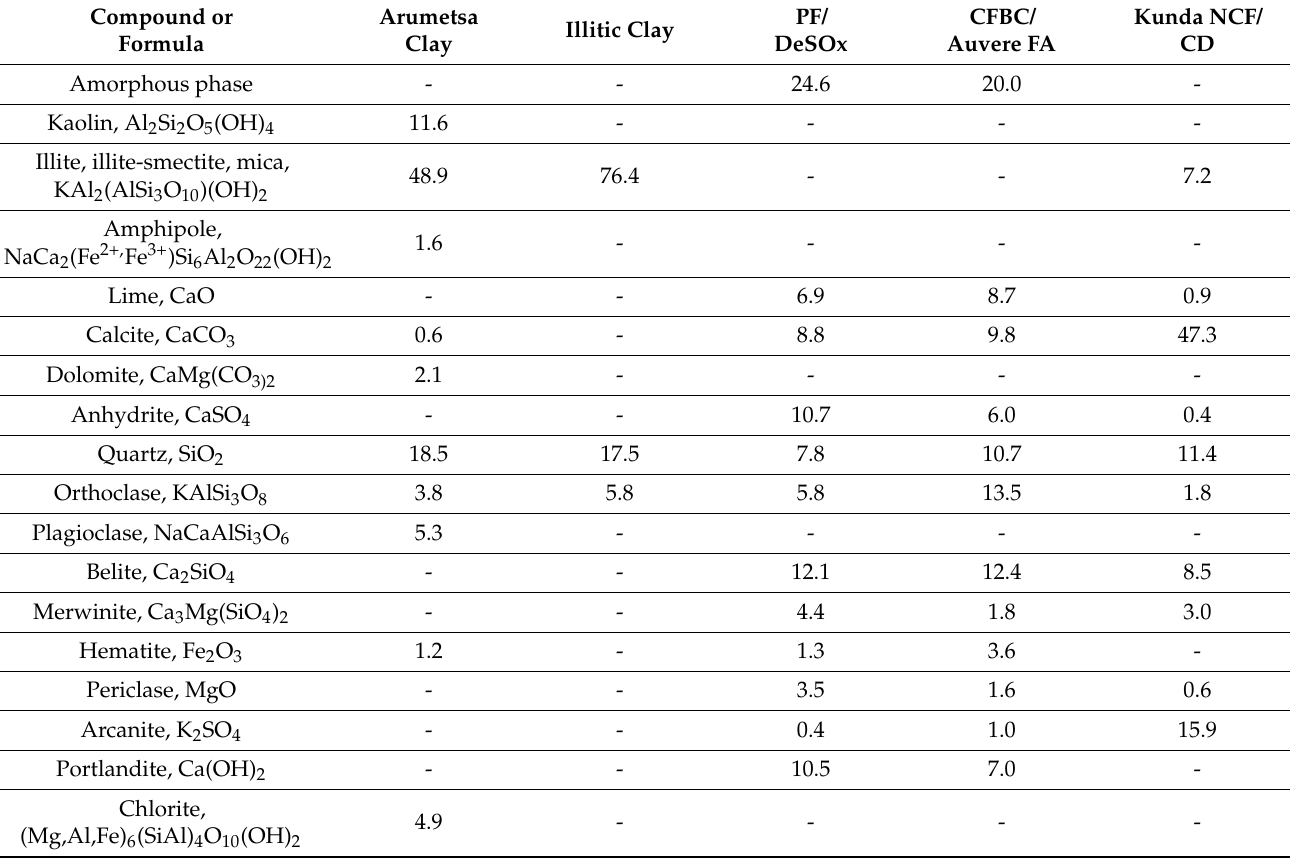
Table 1. Mineralogical compositions (%) of initial samples.